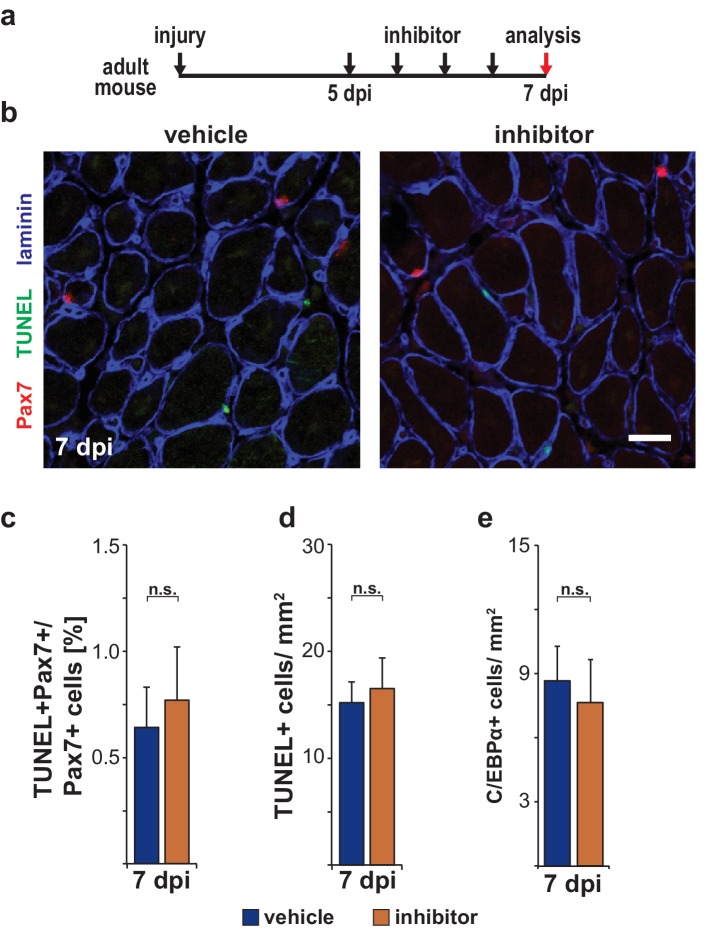
Pharmacological inhibition of Ptpn11 at late stages of muscle regeneration does not induce apoptosis or adipogenesis.(a) Outline of the experiment. (b) Immunostaining for Pax7 (red), TUNEL (green) and laminin (blue) on regenerating muscle after treatment with vehicle or GS493. (c) Quantification of TUNEL+Pax7+/Pax7+ cells. (d) Quantification of TUNEL+ cells/mm2. (e) Quantification of C/EBPα+ cells/mm2. n.s. = not significant, *p<0.05, **p<0.01, ***p<0.001. Error bars show S.E.M. Scale bar: 25 µm.